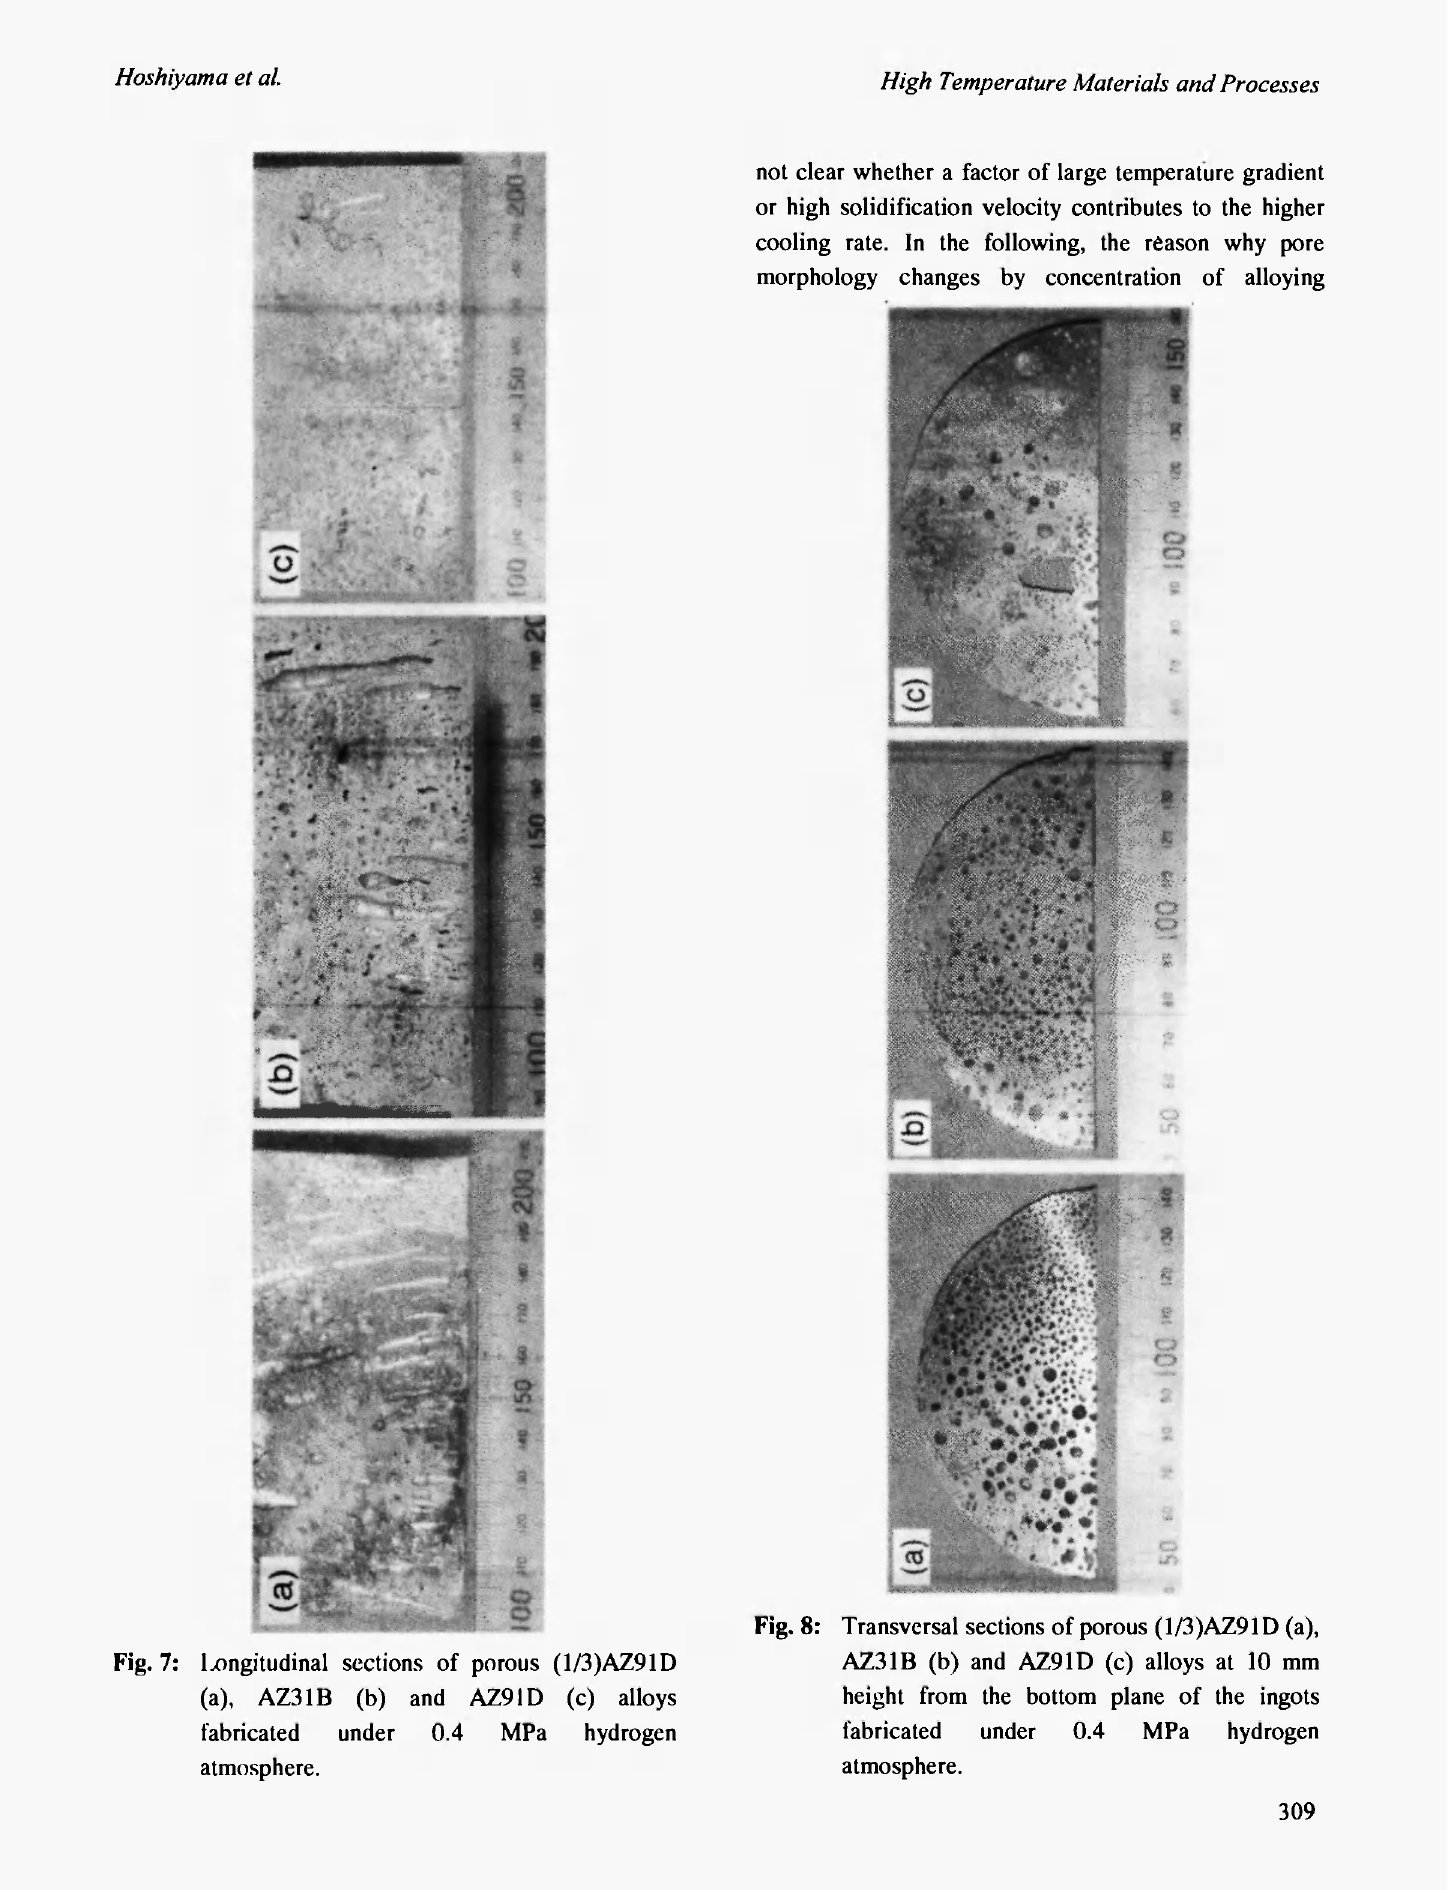
Fig. 7: longitudinal sections of porous (1/3)AZ91D (a), AZ31B (b) and AZ91D (c) alloys fabricated under 0.4 MPa hydrogen atmosphere.